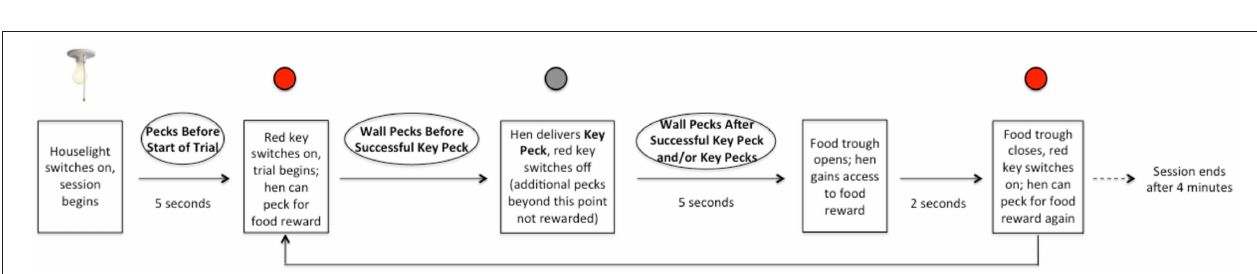
FIGURE 3 | Timeline of 5-s delay schedule of reward.